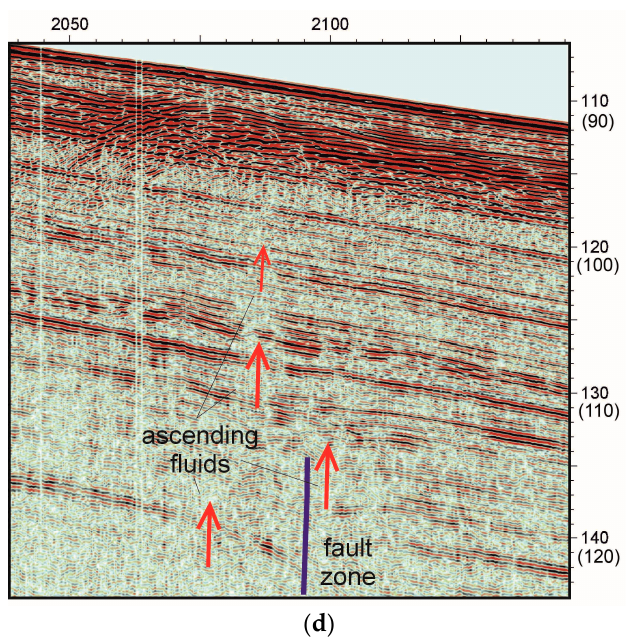
Figure 10. ( a ) Temperature profile, acquired along a 2400 m long fiber cable deployed on the sea floor, and comparison with high resolution seismic profile (see text for details). The latter is parallel to the optical fiber cable and runs at few meters from it (see black line on the box). The profile shows a number of hot discharge points, from about 150 m to 1200 m (at maximum depth of ~40 m) from the Pozzuoli harbor, and from 1700 m to 2250 m (at a depth of ~85 m). The seismic profile shows a number of small-scale tectonic features such as faults (blue lines) and folds, and also highlights the possible occurrence of fluids discharges (red arrows) along the fractured shallow crust. A loose association can be inferred between geological features and temperature variations (see text for details); ( b – d ) Zoom of boxes 1, 2 and 3 of Figure 10a. They show the particulars of the zones with main fluid circulation inferred from the interpretation of the seismic profile. The numbers on the vertical scale refer to the two-way travel time and depth, as showed in Figure 10a.